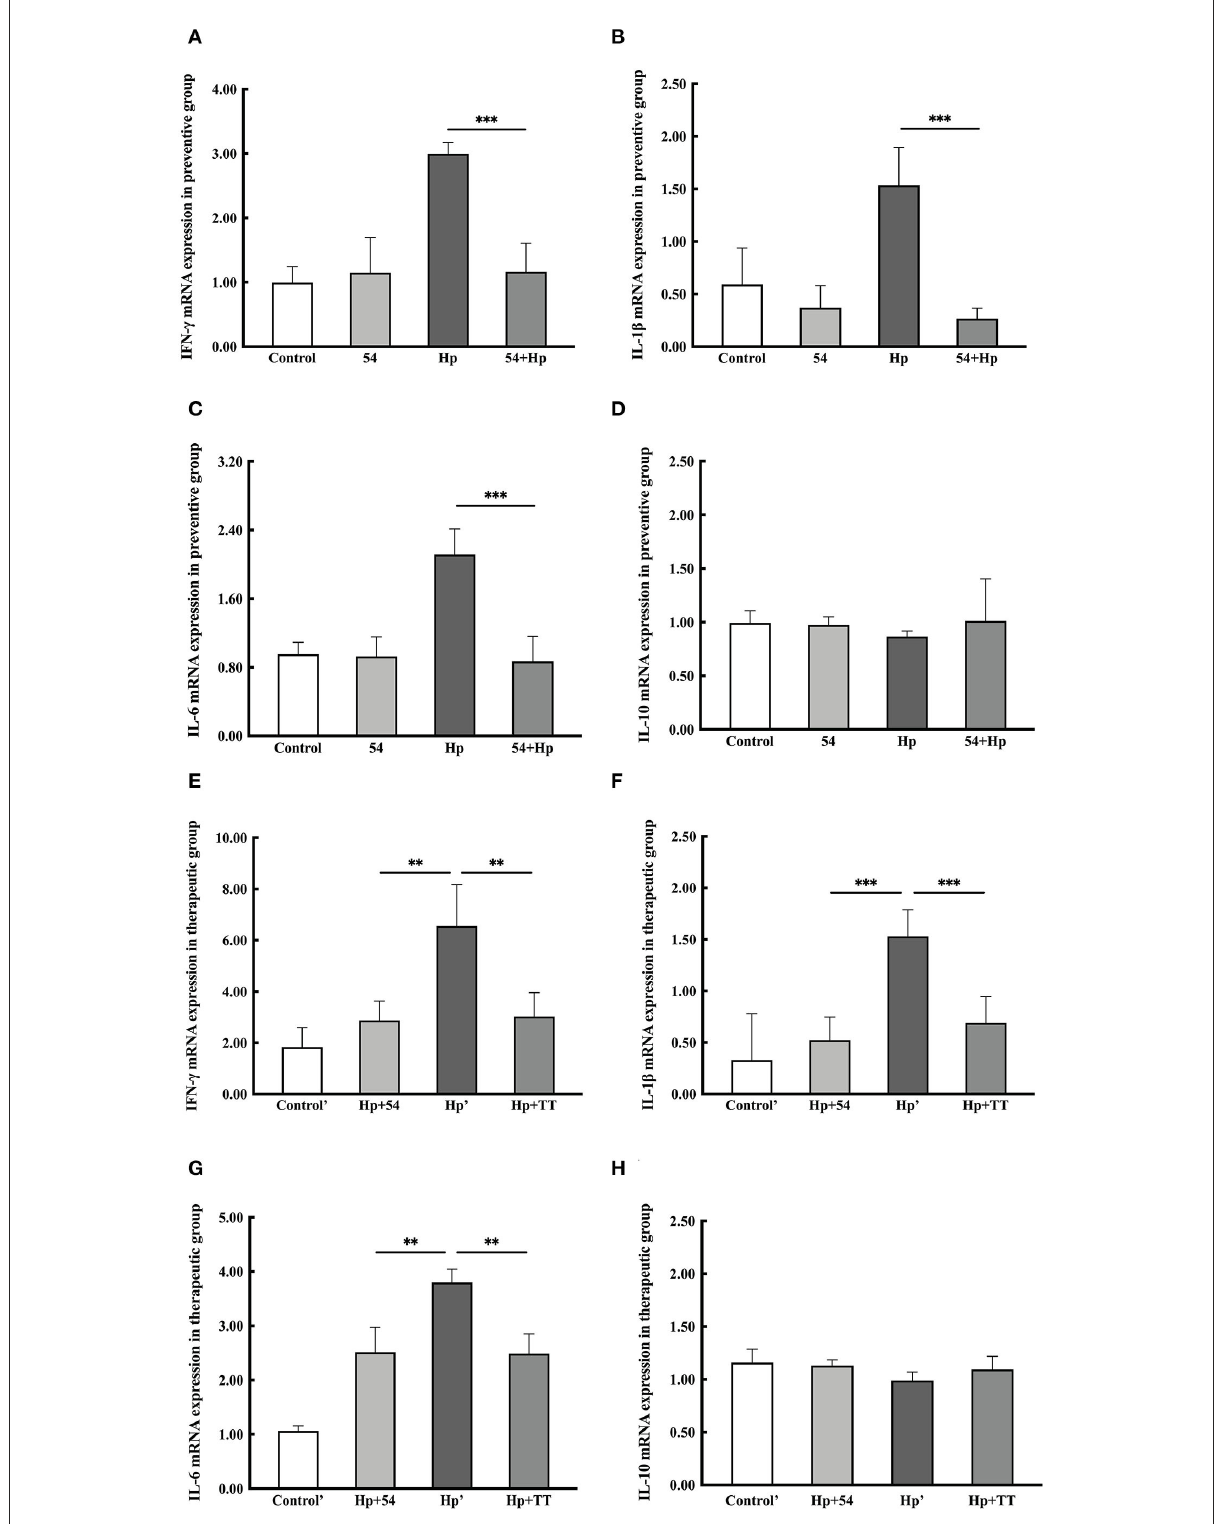
FIGURE6 Expression levels of mRNA for pro-inflammatory or anti-inflammatory cytokines in preventive and therapeutic groups. (A–D) IFN- γ , IL-1 β , IL-6, and IL-10 mRNA expression levels in the preventive group. (E–H) IFN- γ , IL-1 β , IL-6, and IL-10 mRNA expression levels in the therapeutic group. Data are shown as the mean ± SD ( n = 6). Significant differences between two groups based on Student’s t -test, ** p < 0.01, *** p <